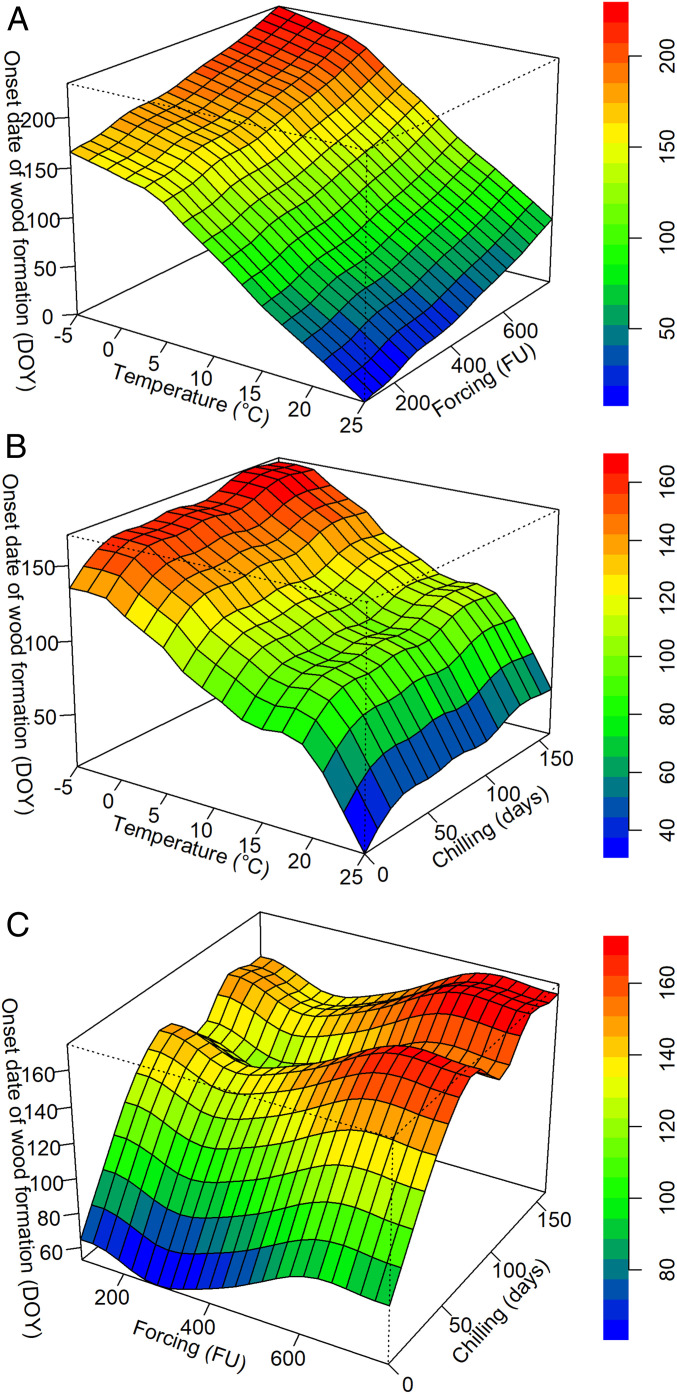
Changes in the onset date of wood formation (DOY) in relation to mean annual temperature (MAT) (abbreviated as “temperature”) and forcing (A), MAT and chilling (B), and forcing (FU) and chilling (C) (fitted by a GAM).